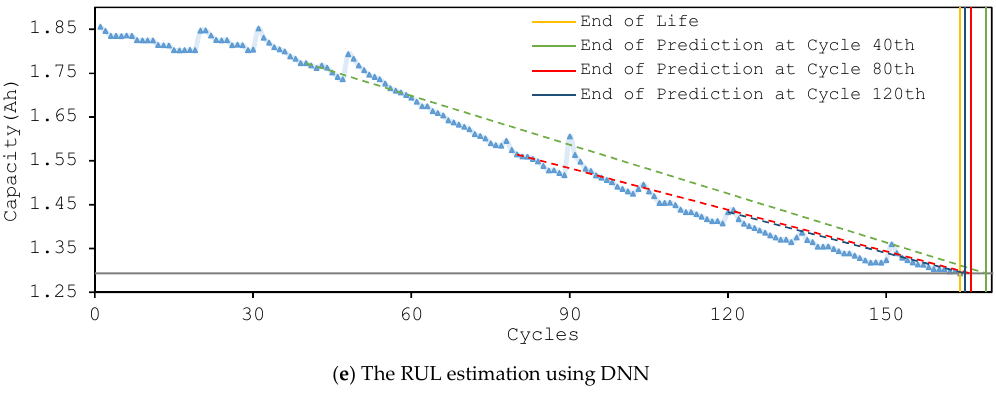
Figure 8. The RUL estimation of battery No. 05 using ( a ) k-NN, ( b ) LR, ( c ) SVM, ( d ) ANN, and ( e ) DNN.